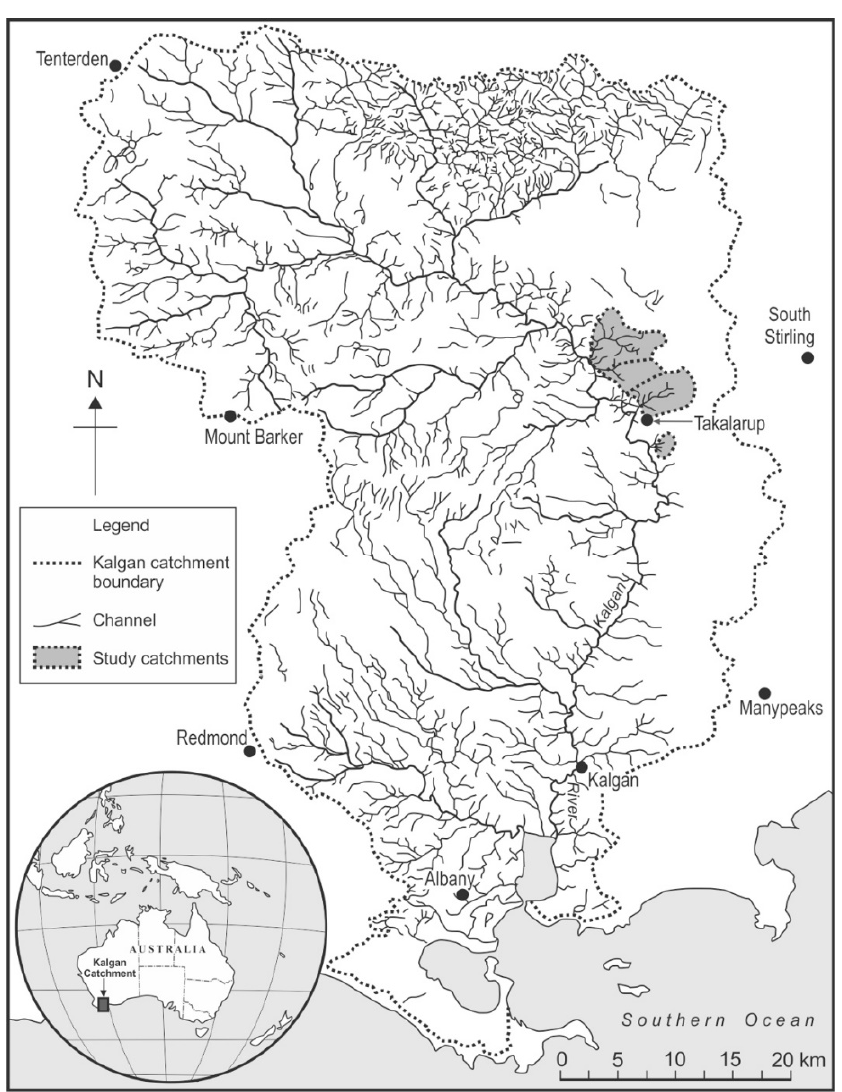
Figure 1. Kalgan catchment, stream network, and study catchment locations.